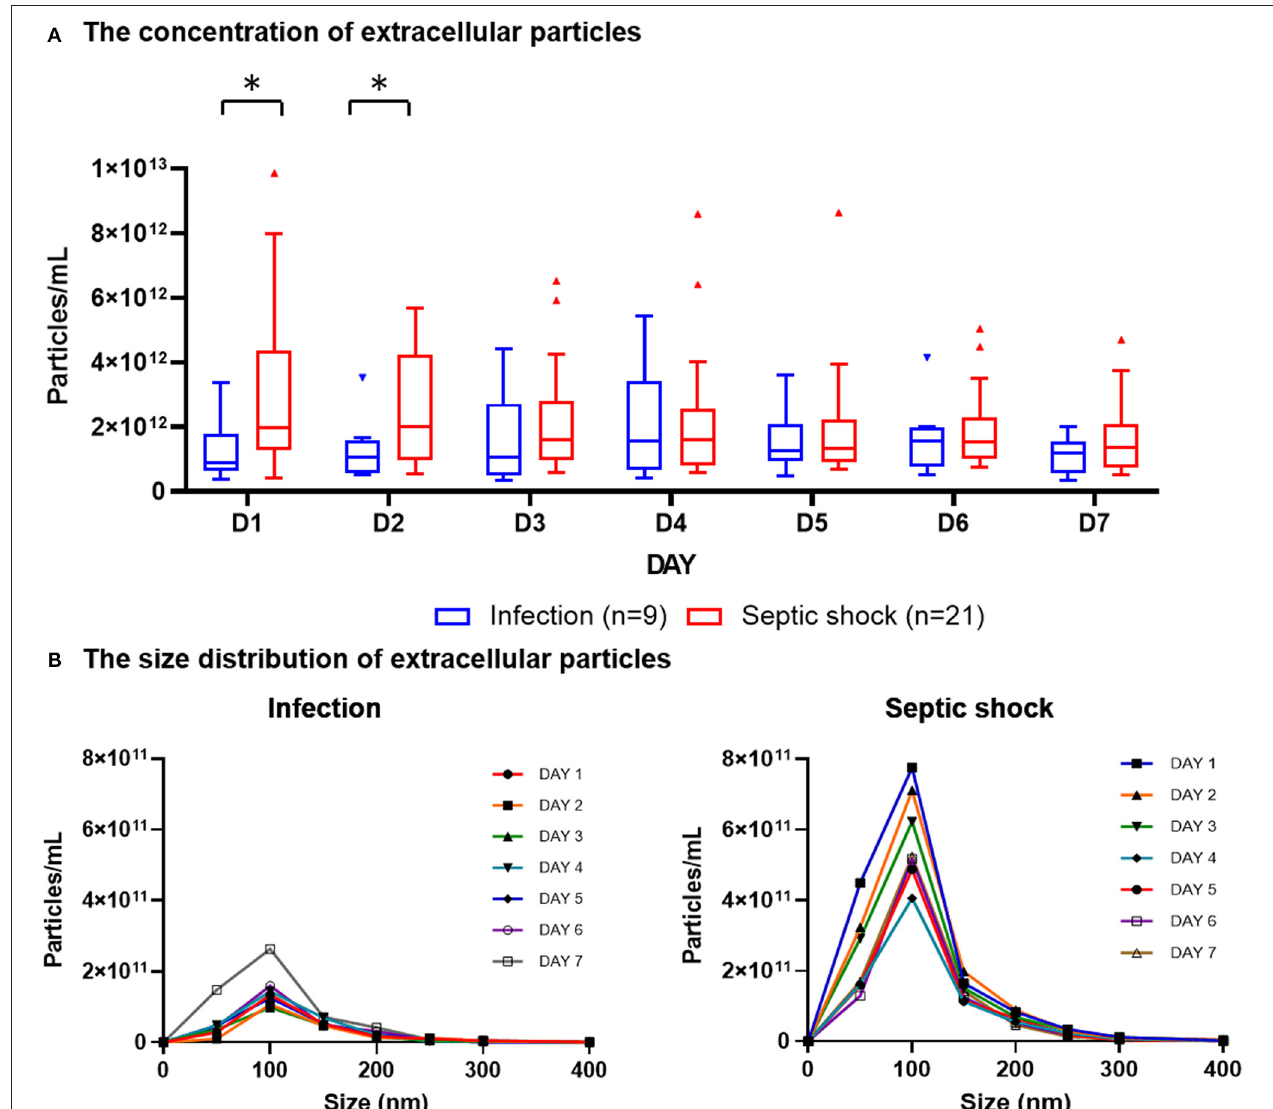
FIGURE 2 | Plasma concentration and size distribution of extracellular particles in PFP samples of patients with septic shock and infection. PFP samples were collected daily for seven consecutive days after hospital admission for analysis. Nanoparticle tracking analysis was employed to measure the concentration of extracellular particles of varying sizes within PFP samples. The daily concentrations of extracellular particles were presented in boxplot graphs using median and interquartile range (A) . The particles varied in sizes, with the majority of them had a diameter of approximately 100nm (B) . Wilcoxon rank-sum tests were performed to compare the concentration of extracellular particles between septic shock and infected patients. * p -value < 0.05 for Wilcoxon rank-sum tests. PFP, platelet-free